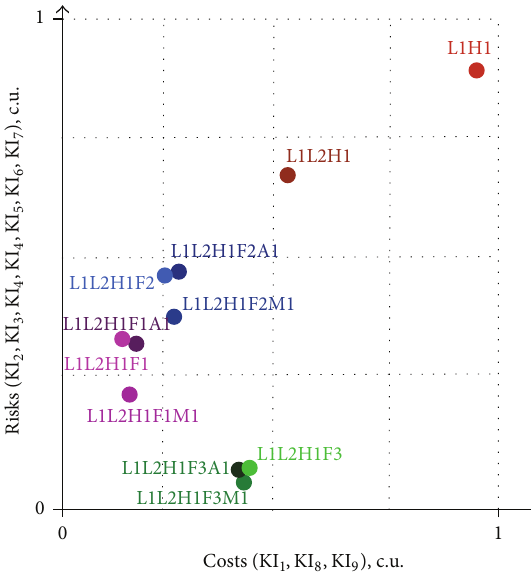
Figure 4: Values of the high-level objectives.